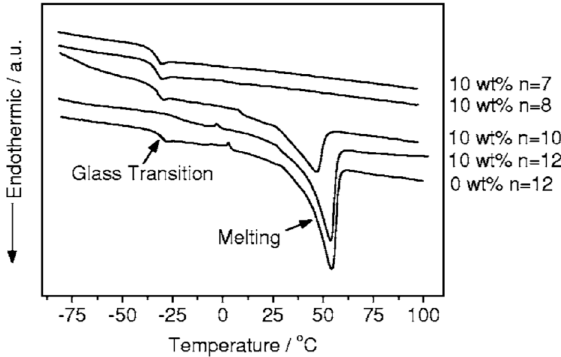
Figure 16. DSC of CPEs containing different wt % active SBA-15 and LiClO 4 concentration ( n = EO:Li + molar ratio) as indicated in the legend. Reproduced with permission from Wang et al. [64]. Copyright 2007, American Institute of Physics.